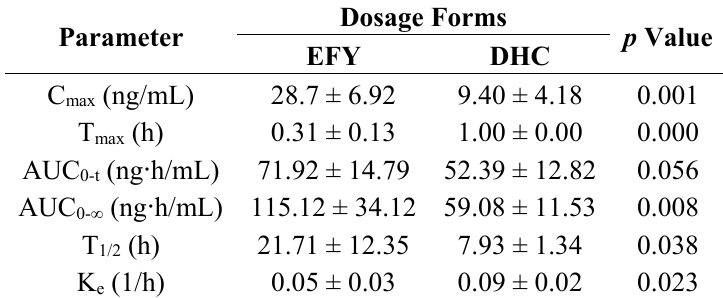
Table 5. Pharamcokinetic parameters of DHC in rats following oral administration, either in an EFY form or in pure form, at an equivalent dose of 97.5